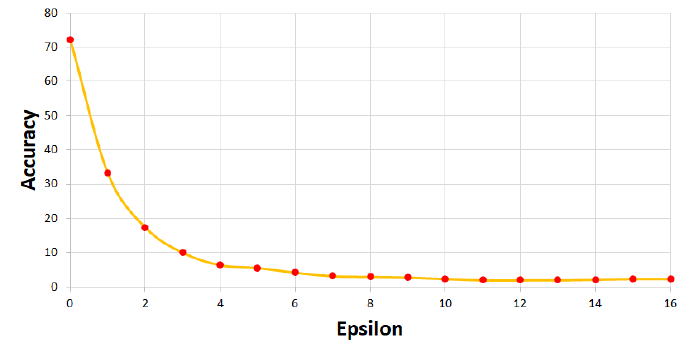
Figure 6. Accuracy drop with various (cid:101)